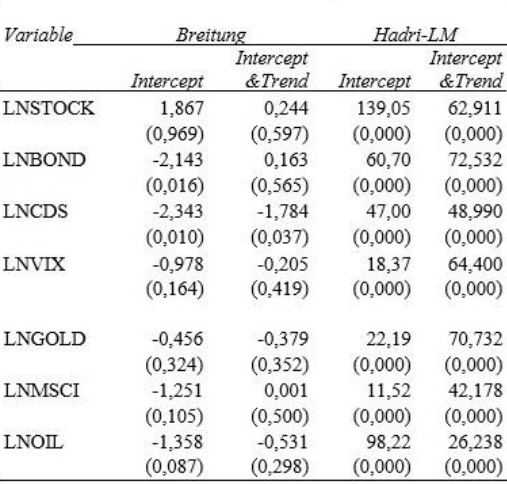
Table 4: Unit Root Test-1